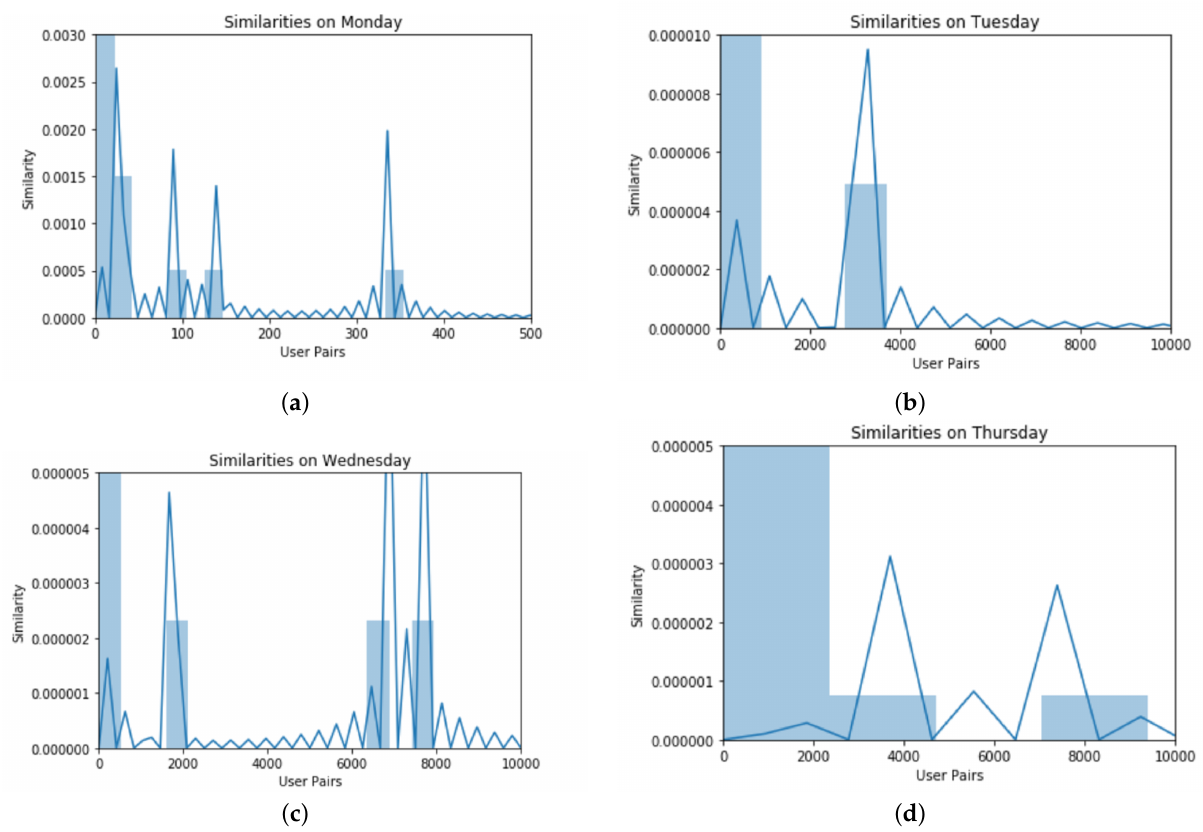
Figure 2. Similarity analysis during different days, ( a ) On Monday, ( b ) On Tuesday, ( c ) On Wednesday, and ( d ) On Thursday. Similarity shows that these users are found on the same location during the same time frame.